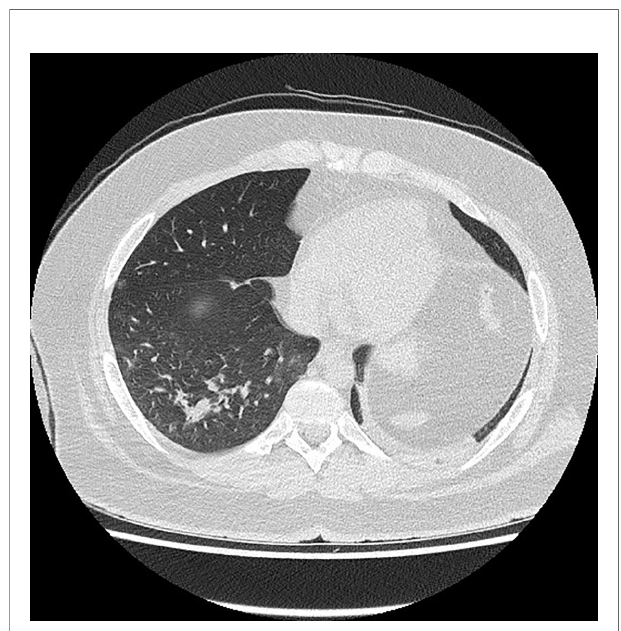
FIGURE 1 | Chest computed tomography